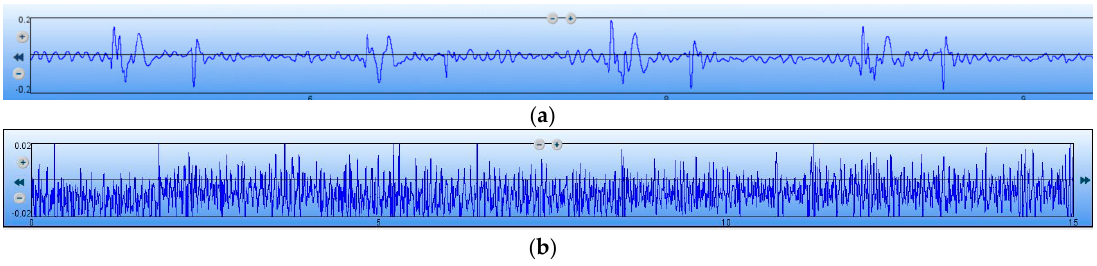
Figure 15. SNR test of the MEMS sensor. ( a ) Heart sound signals; and ( b ) output without the heart sound signals.